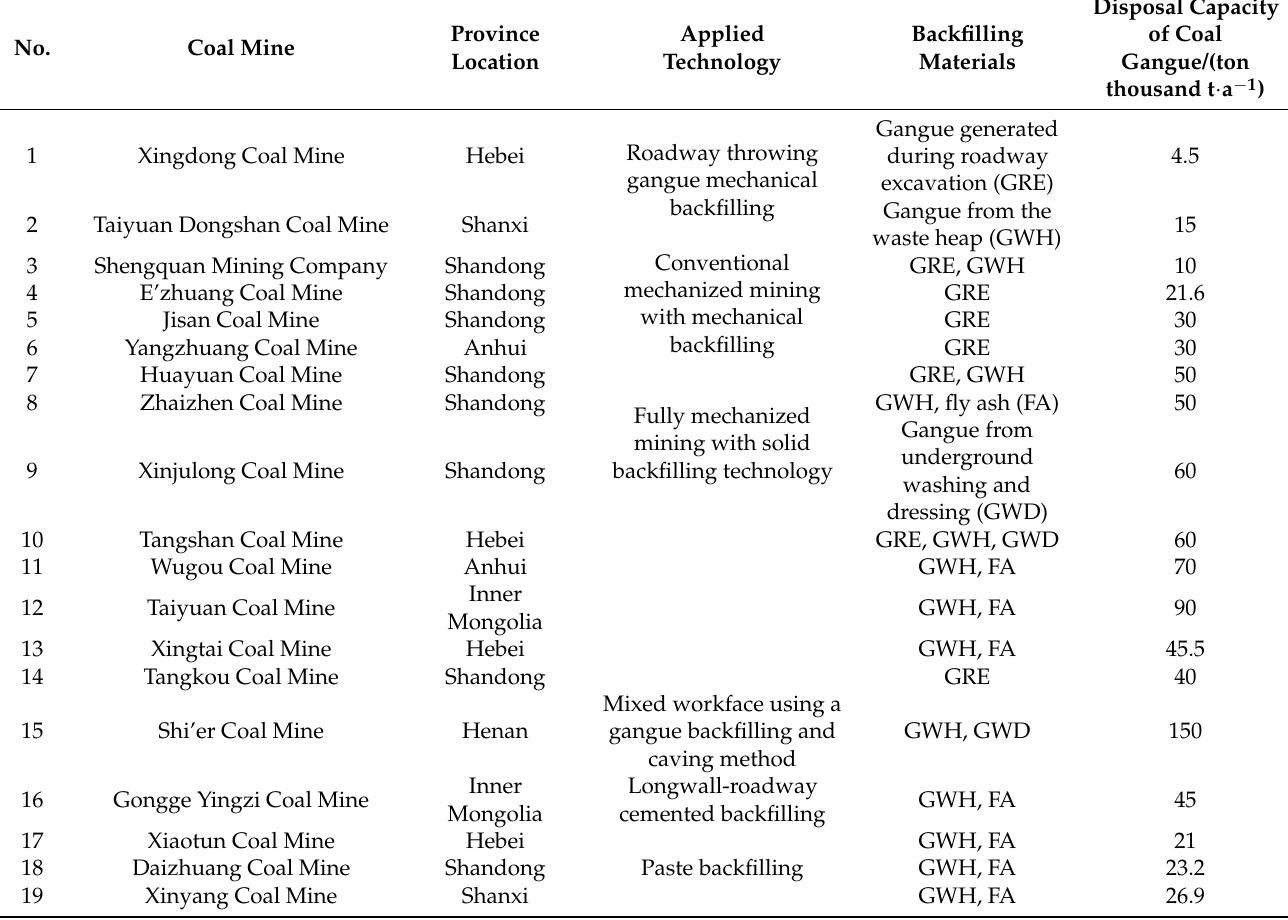
Table 1. The application of the gangue backfilling technologies in some coal mines of